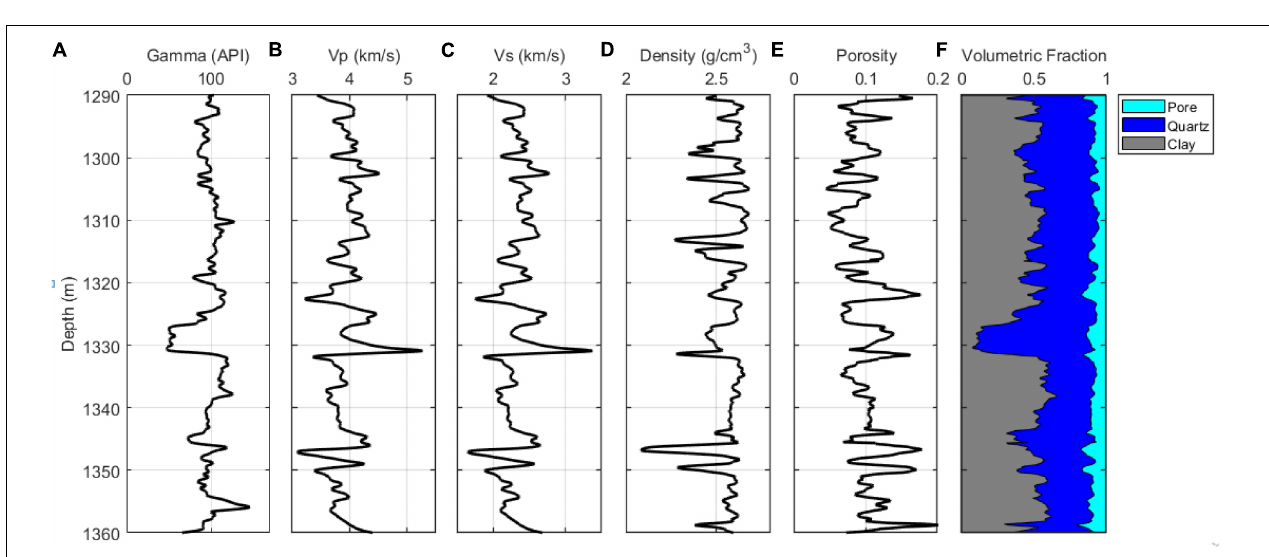
FIGURE 7 | (A) Stacked seismic responses for three gas saturations of 1, 0.6, and 0; (B) spectrum of the PP reflection for a gas saturation of 1; (C) spectrum of the PP reflection for a gas saturation of 0.6; (D) spectrum of the PP reflection for a gas saturation of 0; (E) inverted Dp for the three gas saturation cases.